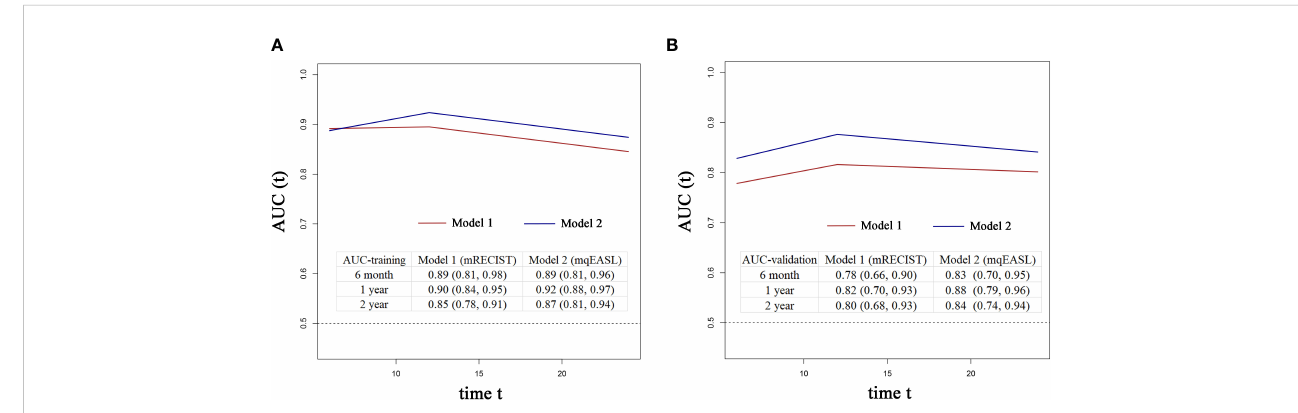
FIGURE 5 Time-dependent AUROC values of Model 1 and Model 2 in the training cohort (A) and validation cohort (B) . The inserted tables show the AUROC values with 95% con fi dence intervals of the models at different time points. AUC, area under the curve.